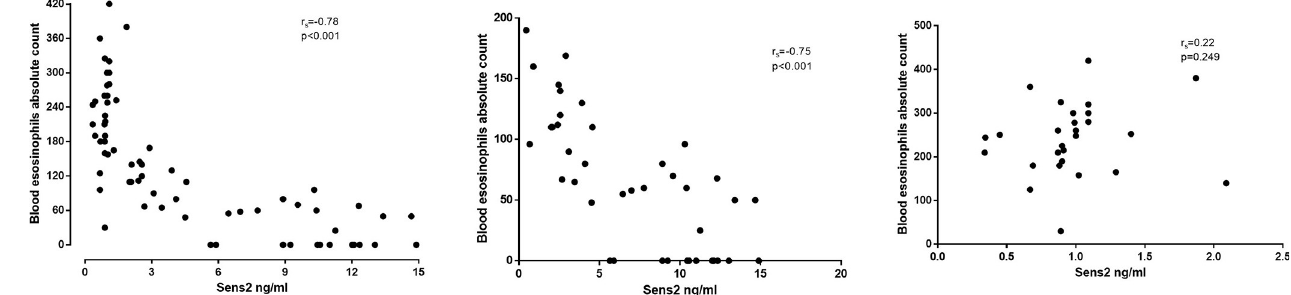
Fig 3. Correlation between Sesn 2 and absolute blood eosinophil number A: All patients, B: patients with emphysema C: Patients without emphysema.